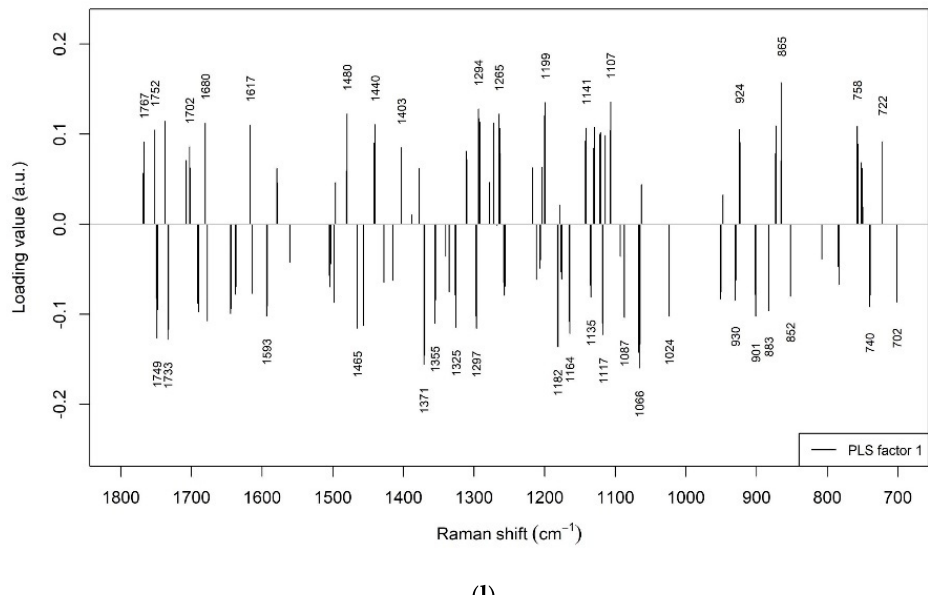
Figure 1. Loading values of first/first two PLS factors employed by the selected models for ( a ) tenderness , ( b ) chewiness , ( c ) stringiness , ( d ) difficulty to swallow , ( e ) crumbliness , ( f ) juiciness , ( g ) beef flavour , ( h ) beef after-effect , ( i ) fatty mouthfeel , ( j ) fatty after-effect, ( k ) metallic flavour, ( l ) metallic after-effect.